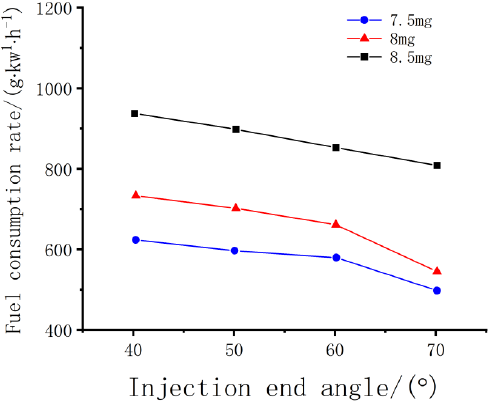
Figure 32. Effect of the injection parameters on fuel